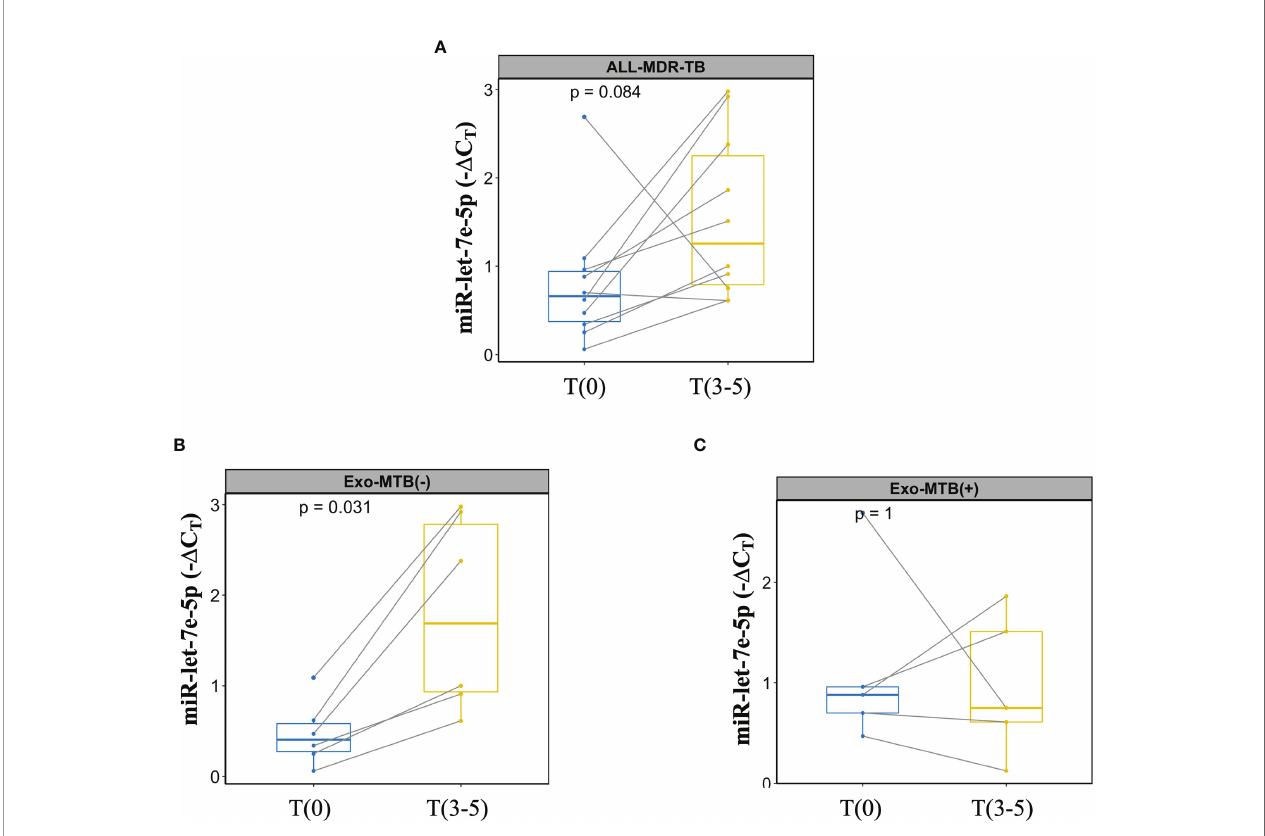
FIGURE 7 | Dual marker evaluation in patients with MDR-TB. Lines show the change in expression for each patient. (A) miR-let7e-5p expression in MDR-TB group, (B) MDR-TB patients negative for 30kDa or 5KST M. tuberculosis sequences. (C) MDR-TB patients positive for 30kDa or 5KST M. tuberculosis